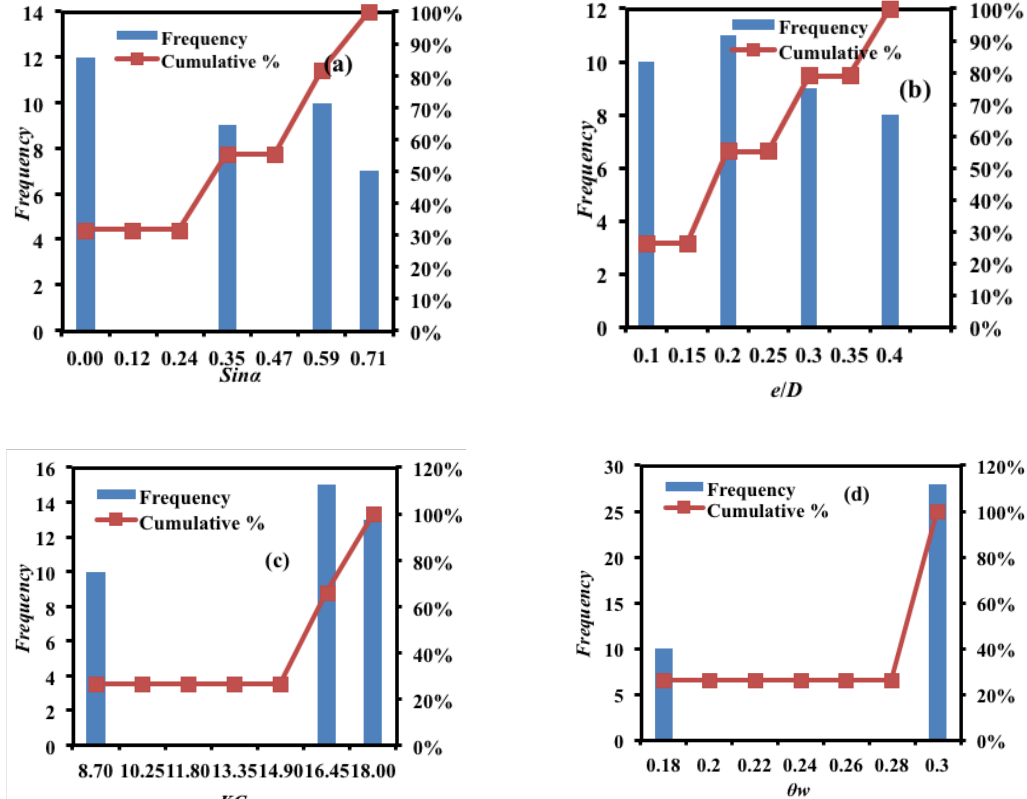
Figure 4. Frequency and cumulative relative frequency for the independent non-dimensional variables.